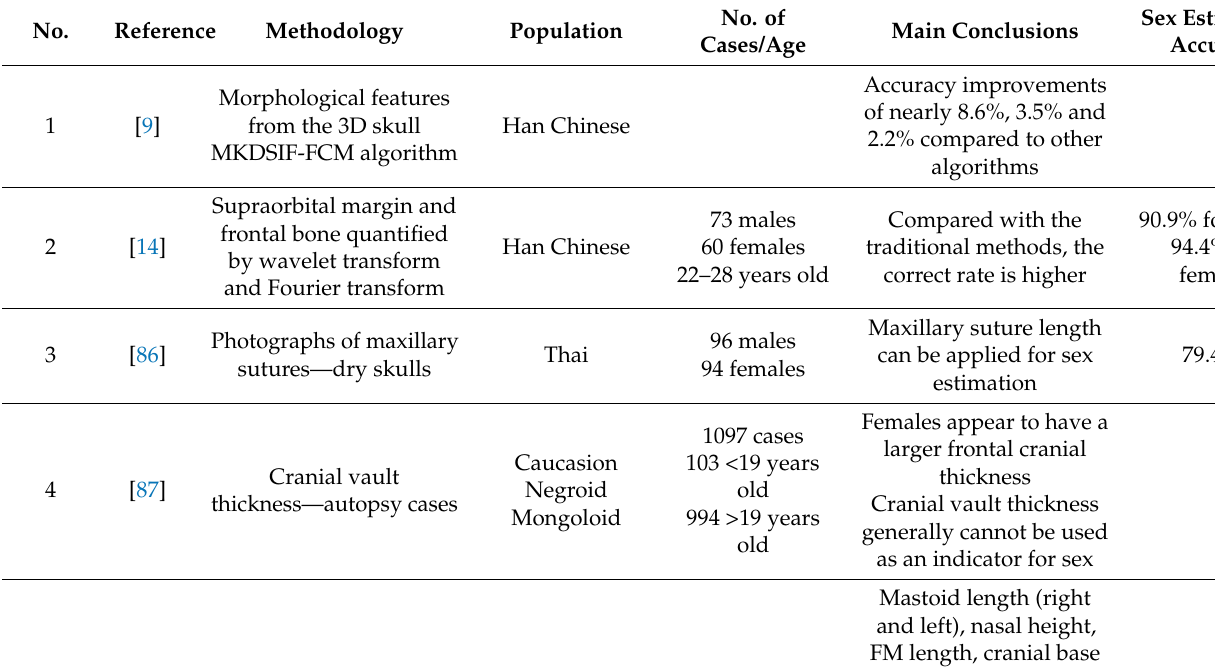
Table 3. Non-radiographic methods (cranial morphometric studies on modern